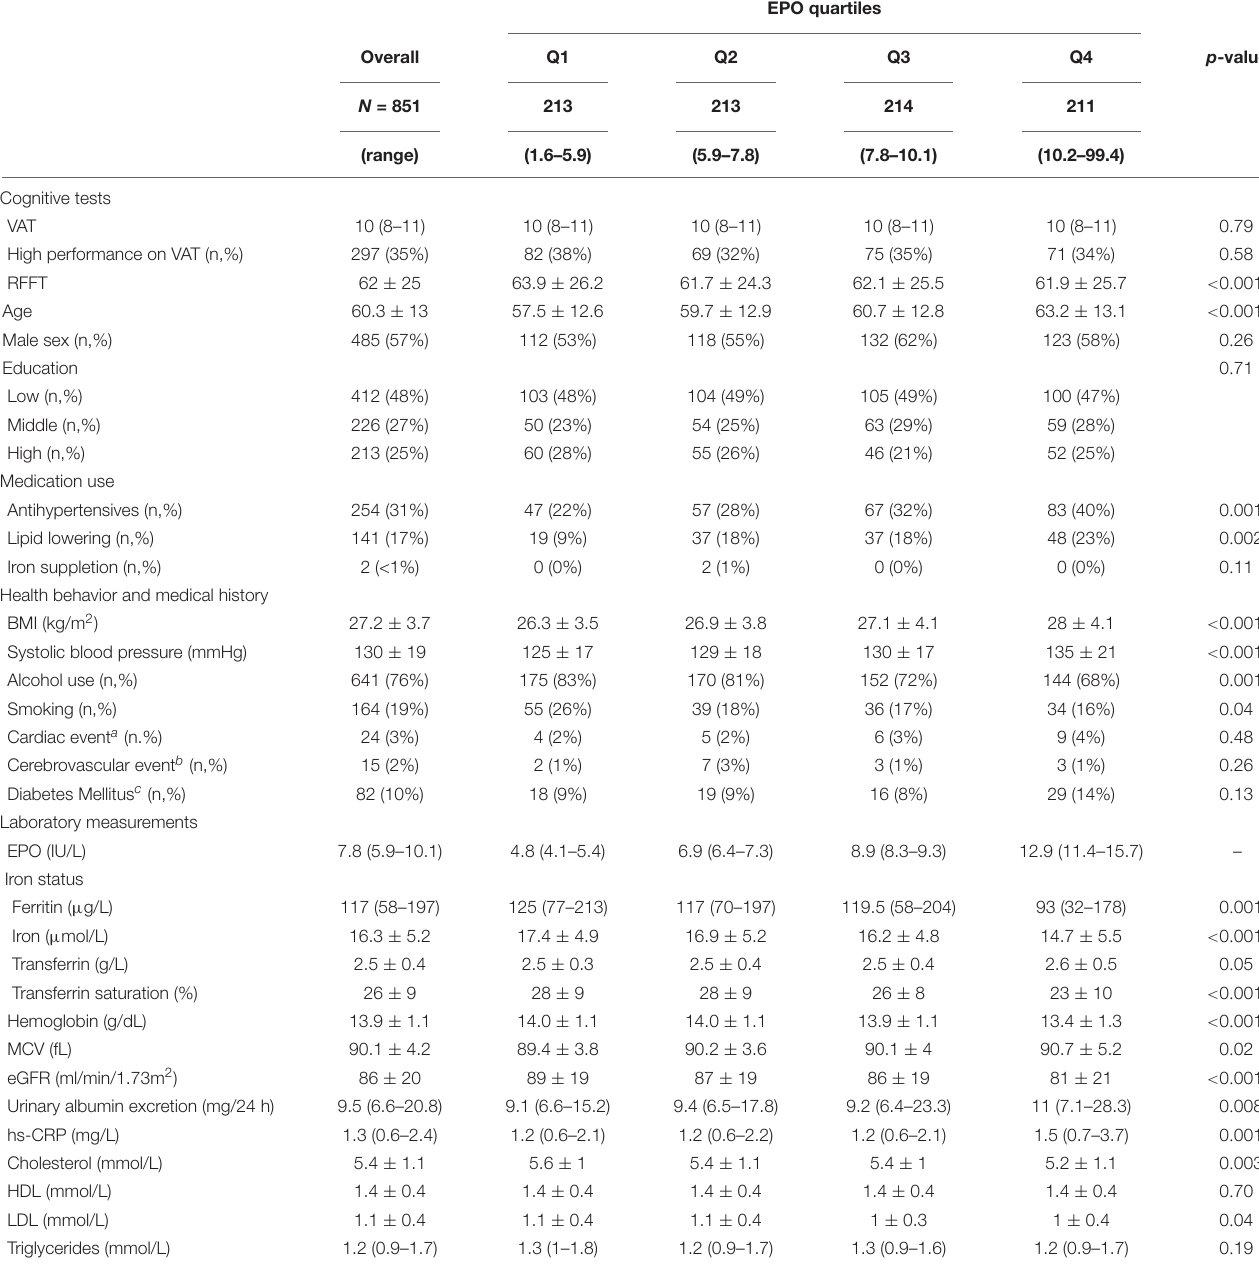
TABLE 1 | Baseline characteristics of 851 community-dwelling subjects according to quartiles of EPO